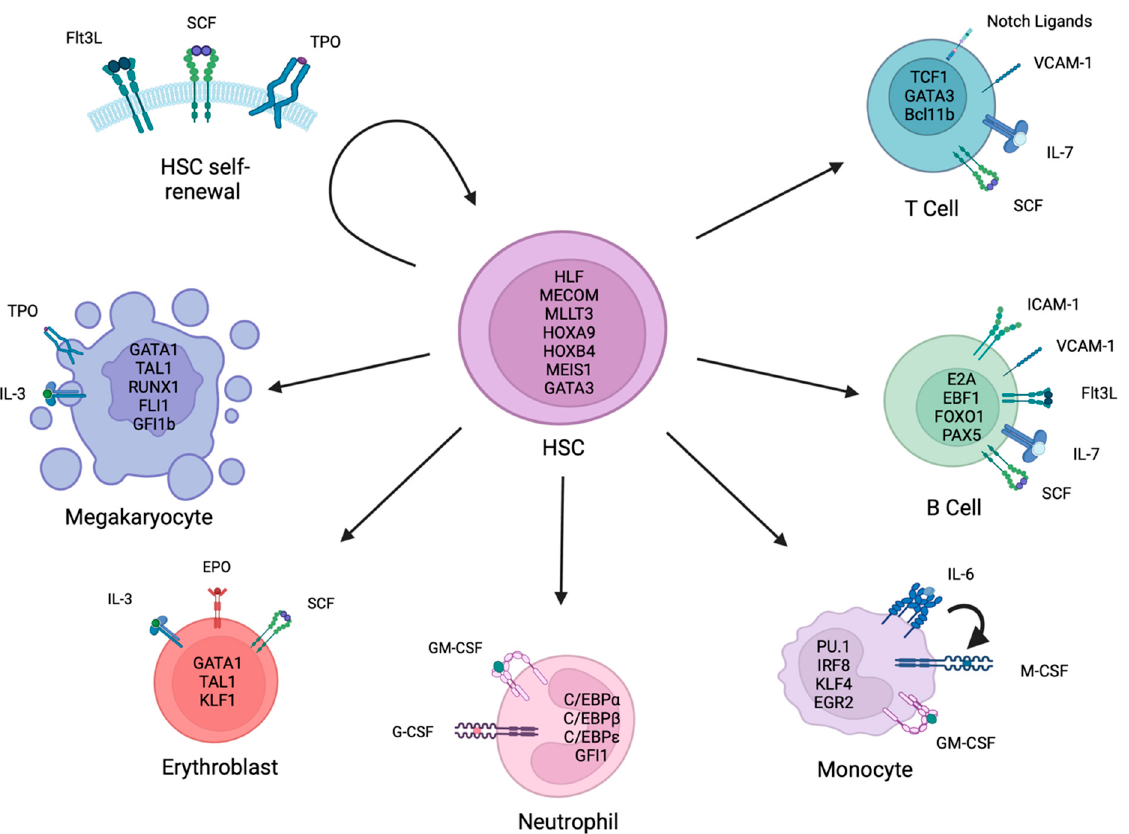
Figure 1. Key factors and pathways involved in haematopoietic stem cell self-renewal and differenti- ation. Haematopoietic stem cells (HSCs) can either self-renew to generate more HSCs or differentiate into the megakaryocyte, erythroid, myeloid (including neutrophil and monocyte) or lymphoid cell (including B cell and T cell) lineages. The key cytokine signalling pathways and transcription factors that regulate HSC self-renewal and differentiation are summarised. This figure was created using www.Biorender.com.